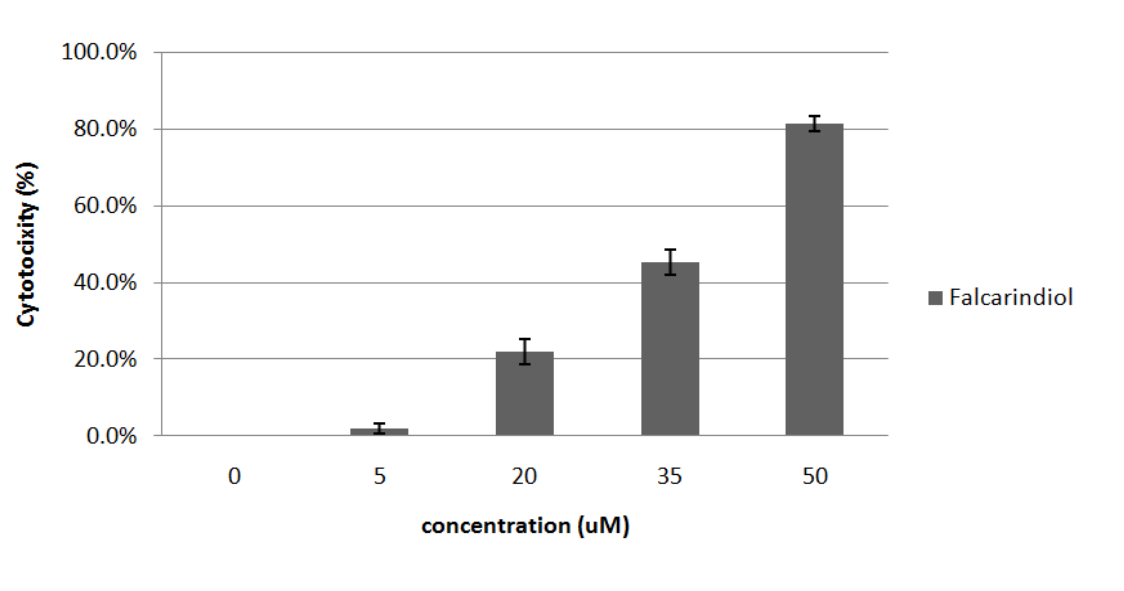
Figure 5. Cytotoxic effect of falcarindiol isolated from DM2 fractions of C. officinale on MCF-7 cells by MTT assay. Measuring cytotoxic effect each experiment was performed in triplicates and repeated at least three times.